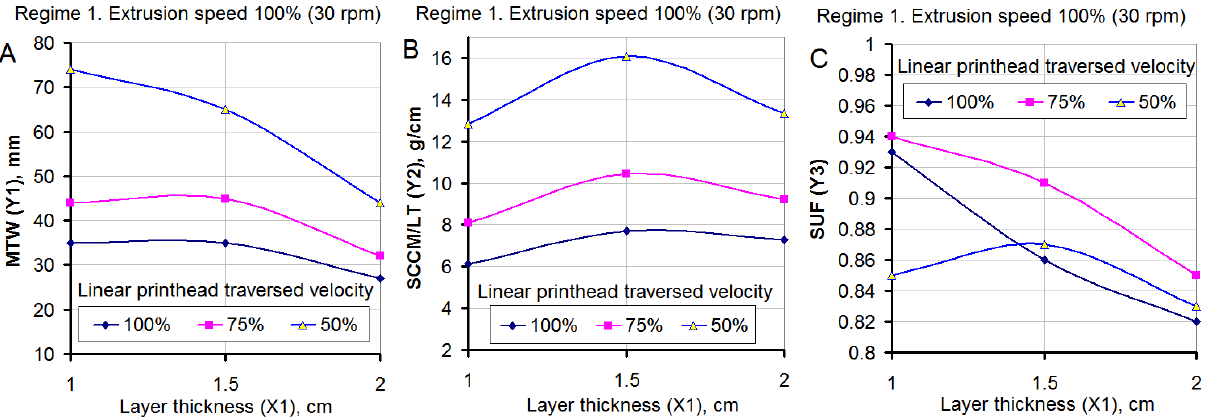
Figure 6. Influence of layer thickness on different print parameters when extrusion speed is con- stant (Regime 1 : ( A ) maximum track width; ( B ) specific consumption of the “concrete mixture/layer thickness” ratio; ( C ) section utilization factor